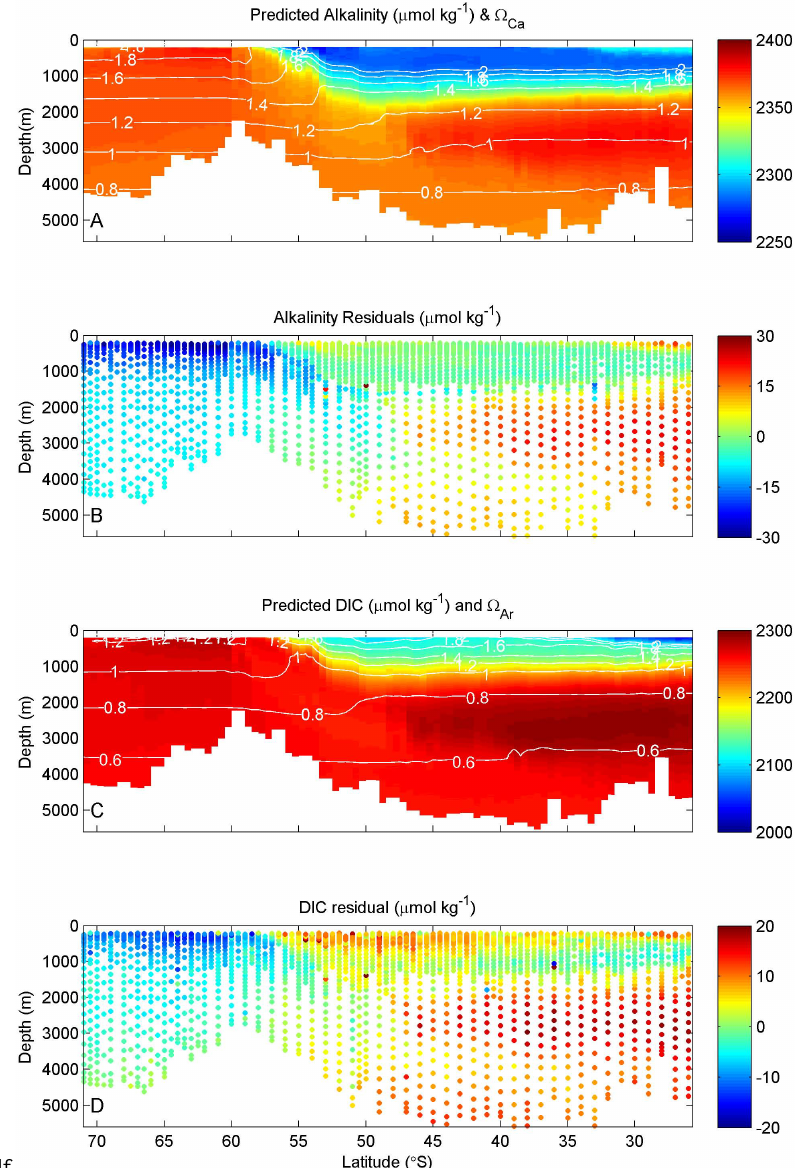
Fig. 5. P16S transect. Predicted alkalinity and DIC from the hydrographic data from CLIVAR transect P16 2005 using the MLR algorithms. (A) Alkalinity (with (cid:127) calcite overlain), (B) residuals between (A) and the measured bottle data shown in Fig. 2, (C) DIC (with (cid:127) aragonite overlain), (D) residuals between (C) and the measured bottle data shown in Fig.